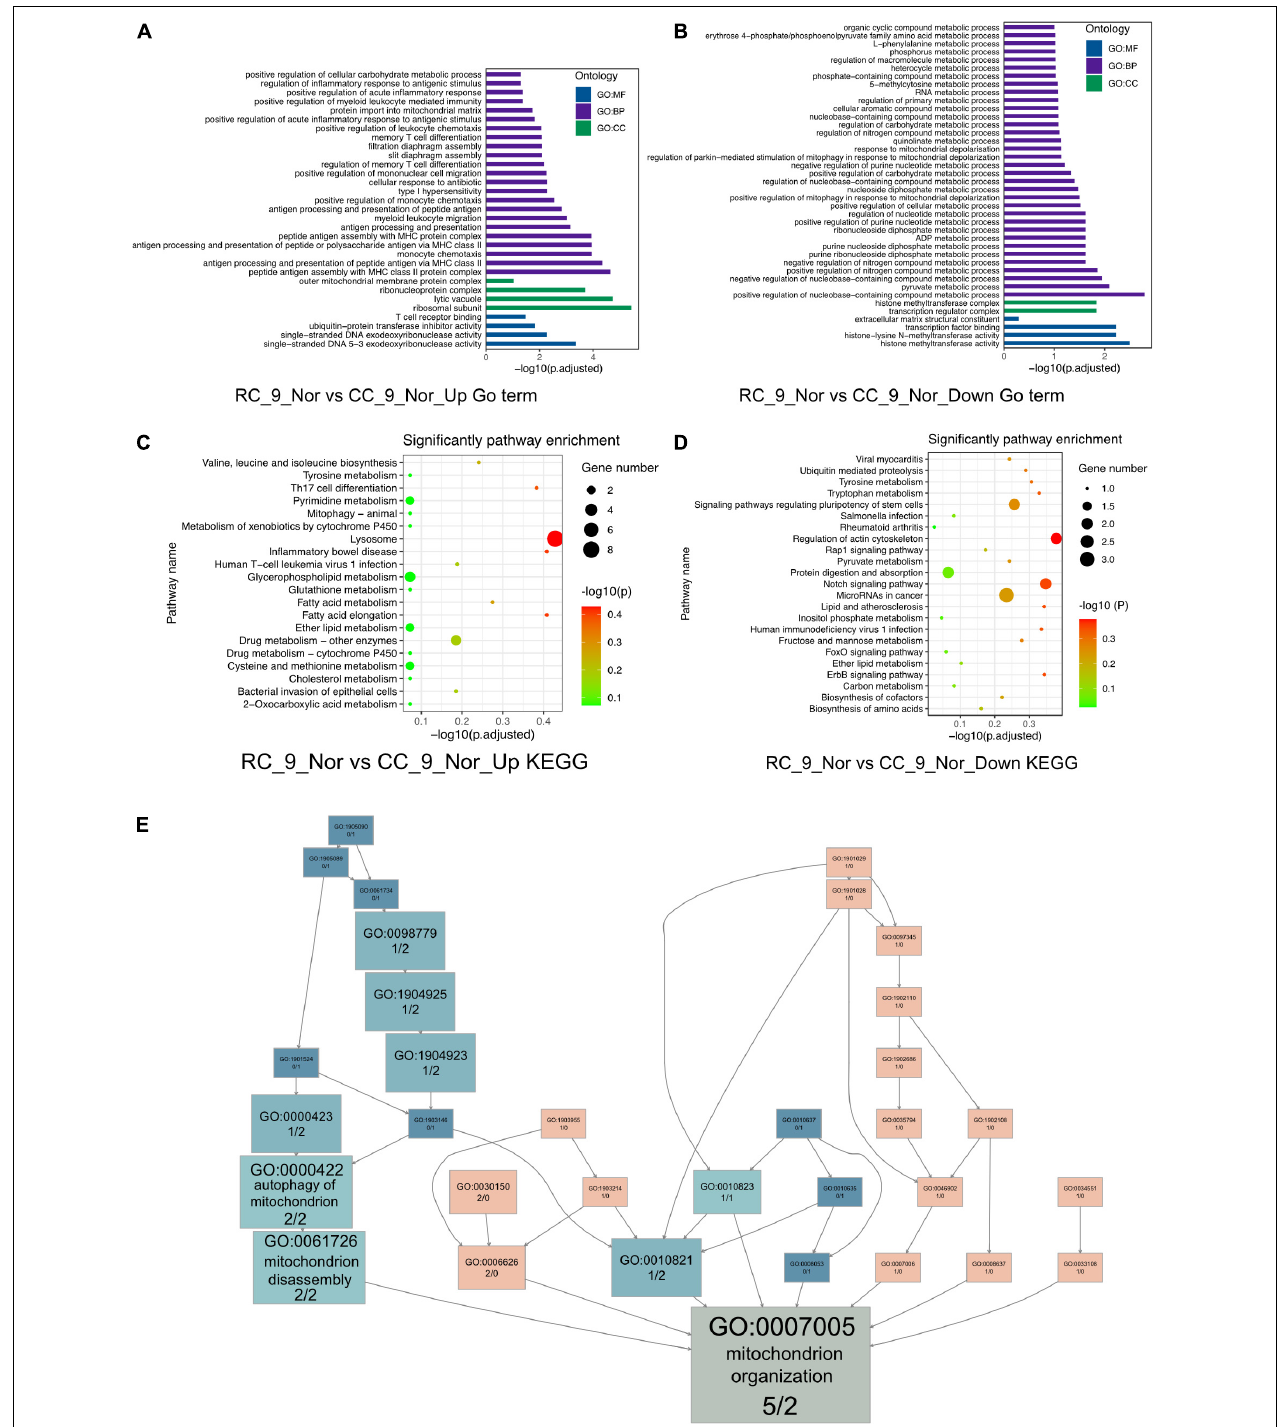
FIGURE 2 | The GO and KEGG analysis of the DEGs (RC_9_Nor vs. CC_9_Nor) in the cardiac muscle samples of the rats. (A) The GO enrichment analysis of upregulated DEGs in RC_9_Nor and downregulated DEGs in CC_9_Nor. (B) The GO enrichment analysis of downregulated DEGs in RC_9_Nor and downregulated DEGs in CC_9_Nor. (C) The KEGG enrichment analysis of upregulated DEGs in RC_9_Nor and downregulated DEGs in CC_9_Nor. (D) The KEGG enrichment analysis of downregulated DEGs in RC_9_Nor and downregulated DEGs in CC_9_Nor. (E) The GO tree of 7 mitochondrion-related DEGs in mitochondrion organization